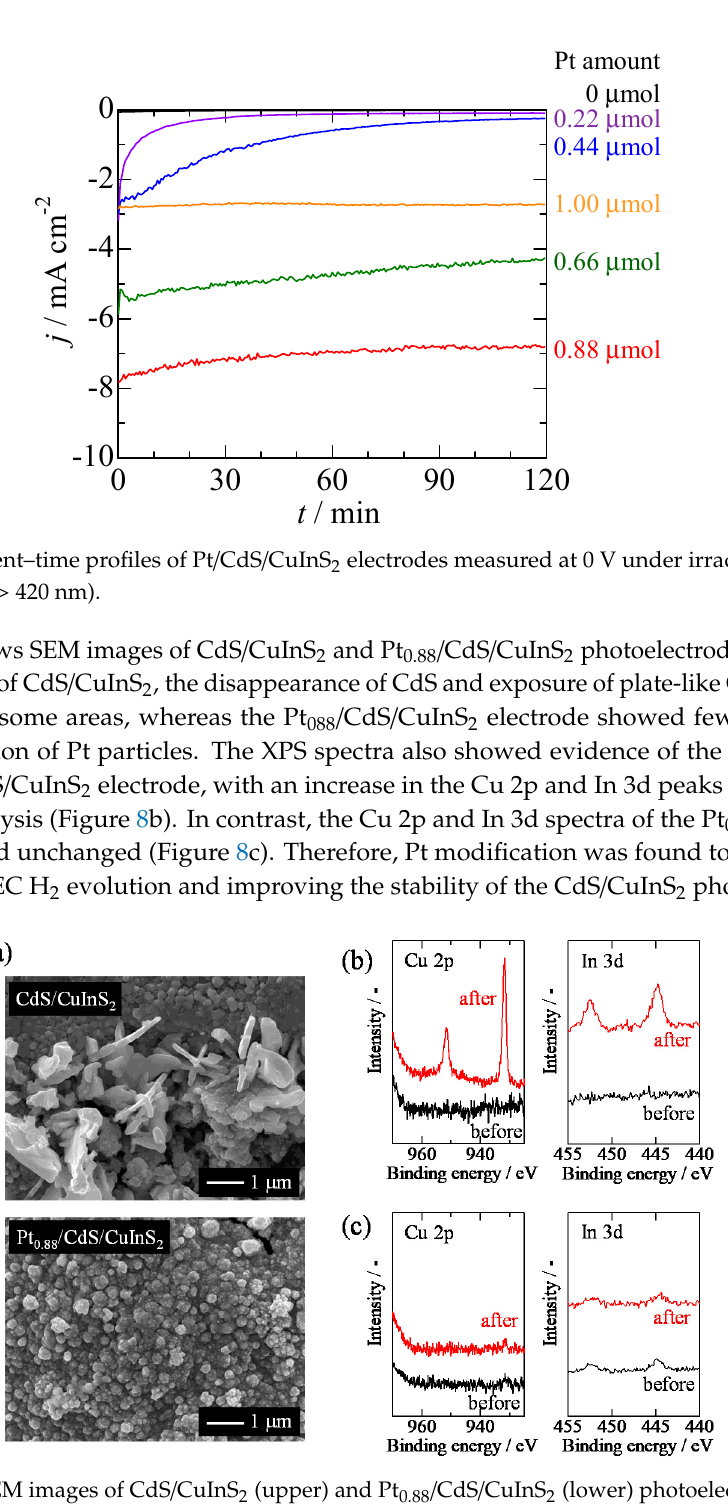
6 of 12 Figure 6. Time course curves of H 2 evolution (closed circles) from Pt/CdS/CuInS 2 electrodes measured at 0 V under irradiation with visible light ( λ > 420 nm). The broken lines denote time course curves of half of the electrons passing through the outer circuit (e – /2). Figure 7 shows typical photocurrent time profiles measured during PEC H 2 evolution experiments. These results indicate that the stability of the Pt/CdS/CuInS 2 photoelectrodes